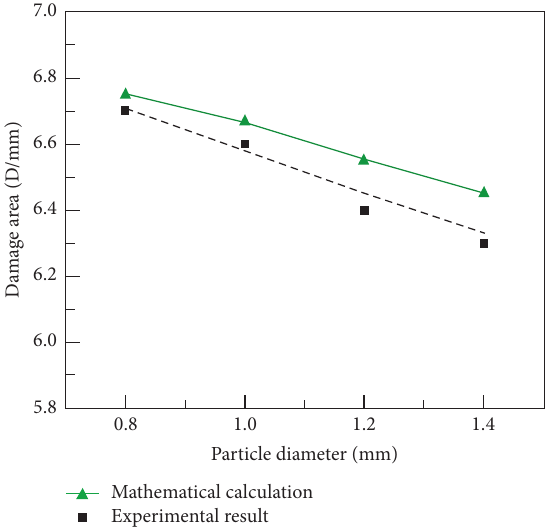
Figure 13: Effect of particle diameter on damage area (test time with 10s; water-jet impact velocity with 205m/s; impact angle with 8 ° ).